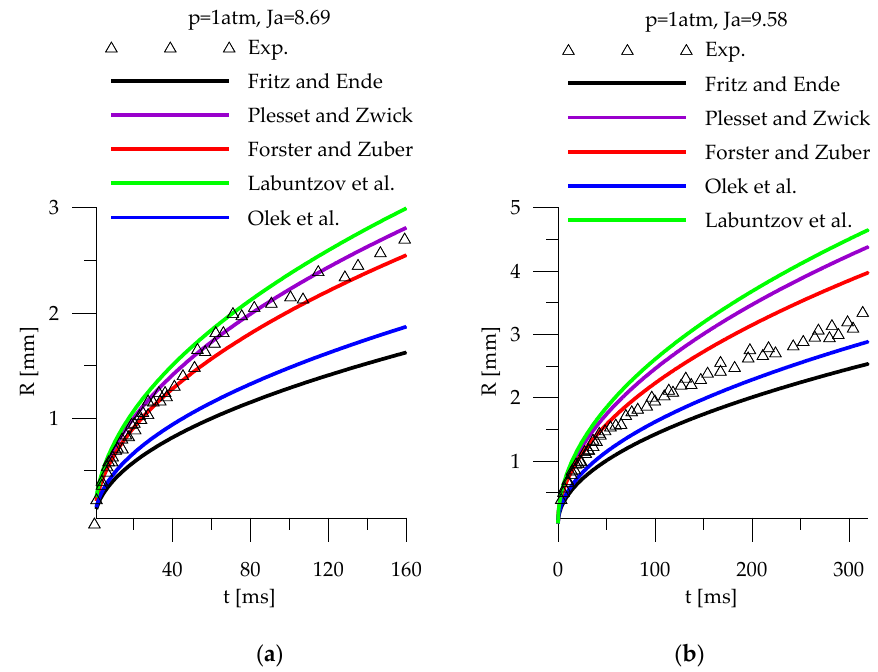
Figure 9. Simulated and measured bubble growth at zero gravity (experimental data from [20]):